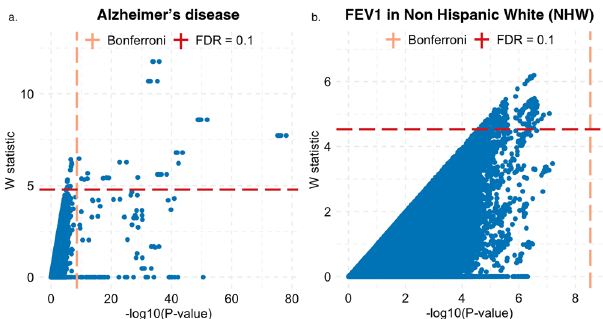
Fig. 8 Scatter plot of genome-wide W statistic vs. − log10 ( p -value). Each dot represents one variant/window. The dashed lines show the signi fi cance thresholds de fi ned by Bonferroni correction (for p -values) and by false discovery rate (FDR; for W statistic). The p -values are from the conventional association testing described in the main text. Source data are provided as a Source Data fi